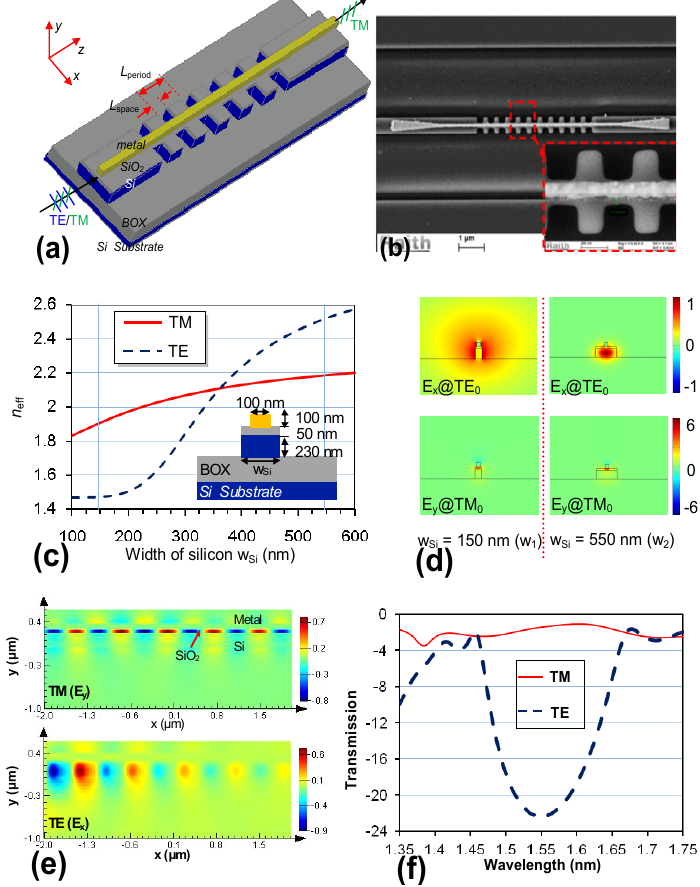
Figure 9. ( a ) Configuration of the TM-pass polarizer based on a silicon grating with a narrow metal strip on the top; ( b ) SEM picture for the fabricated polarizer; ( c ) the effective indices for TE- and TM-polarizations as the silicon core width w Si varies from 100 nm to 600 nm; ( d ) the modal field profiles ( E x , E y ) for TE- and TM-polarizations when w Si = 100 nm, and 500 nm, respectively; ( e ) Simulated light propagation in the designed polarizer for TE- and TM-polarizations; ( f ) Simulated transmission spectral responses [22].